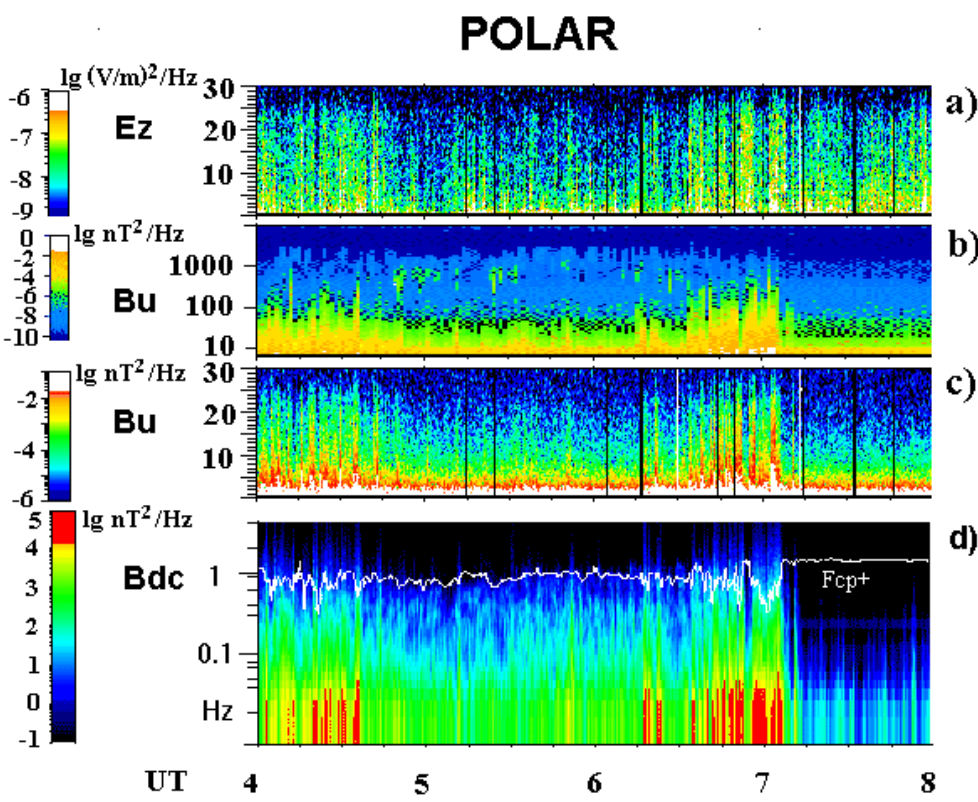
Fig. 2. Panels (a), (c) : electric E z and magnetic ( B u ) Fourier spectrograms in the spacecraft frame from the PWI instrument (note the linear frequency scale on the vertical axes for E z and low frequency B u (panel c) and the logarithmic scale on panel (b). Panel (b) : B u aboard spectra. Panel (d) : Fourier spectrogram of the total power of the DC magnetic field (sampling rate 8Hz, MFE experiment); the white line depicts the proton cyclotron frequency labeled